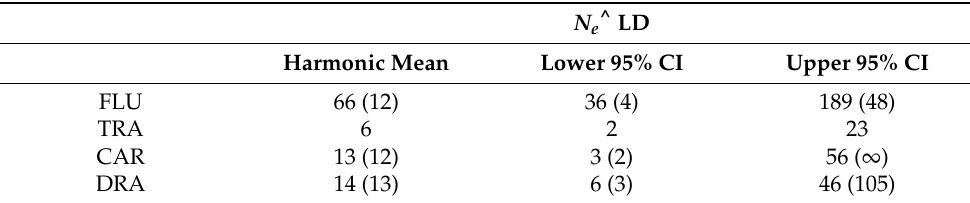
Table 2. Within-population genetic estimates in Esox spp. Mean contemporary effective population size estimated using the Linkage Disequilibrium method ( N e^ LD).